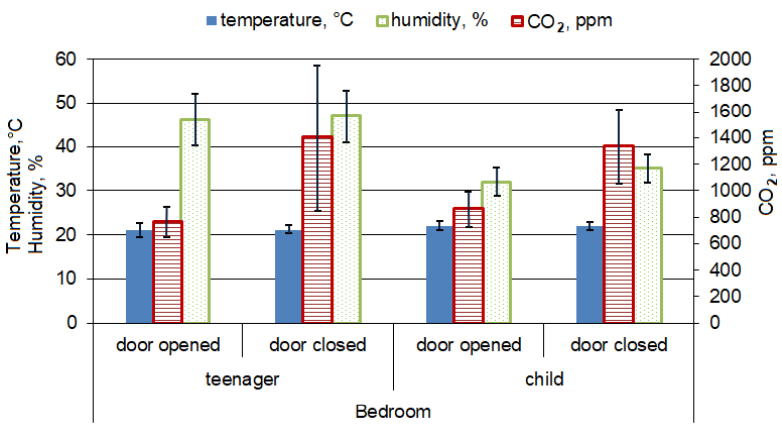
Figure 3. Mean temperature, relative air humidity, and CO 2 concentration inside the teenager’s and child’s bedrooms during the night.